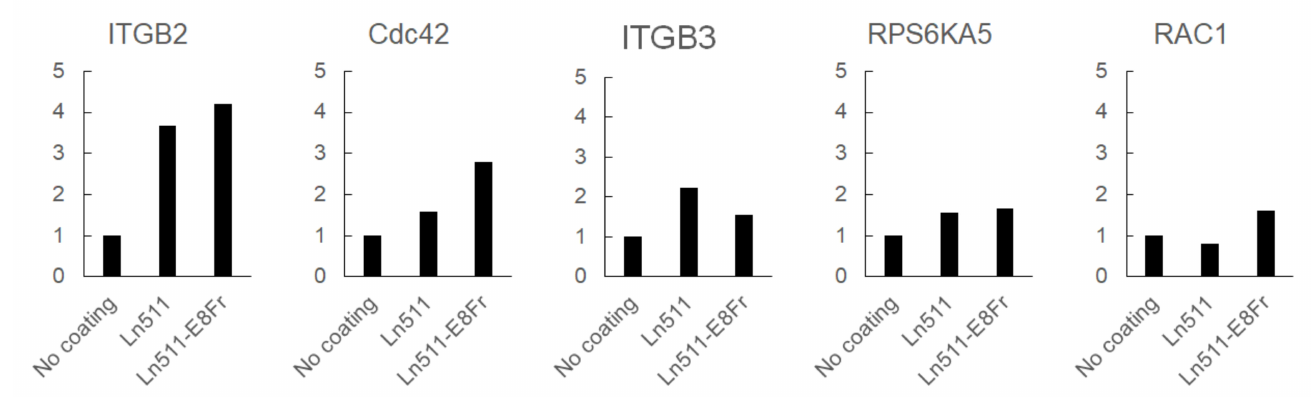
Figure 7. The five most upregulated genes in SH-10-TC cells cultured on Ln511 or Ln511-E8 fragment compared with the control (no coating) based on 96-well plate-based gene expression analysis. The difference in mRNA expression between control (no coating) and other samples was largest for integrin subunit beta 2 (ITGB2), followed by Cdc42, integrin subunit beta 3 (ITGB3), ribosomal protein S6 kinase A5 (RPS6KA5), and RAS-related C3 botulinus toxin substrate 1 (RAC1). Data were obtained from a single experiment using gene expression array plates.